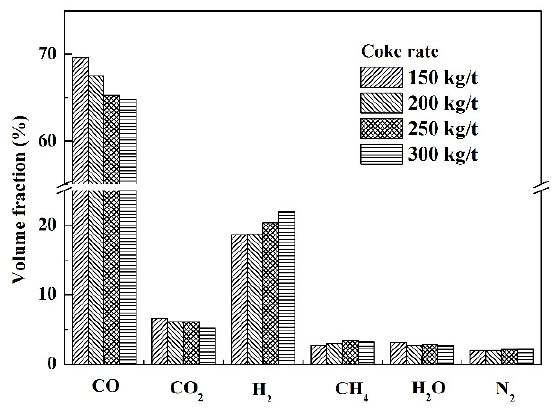
Figure 8. Volume fraction of generator gas after COG injection under the melting rate 160 t/h.